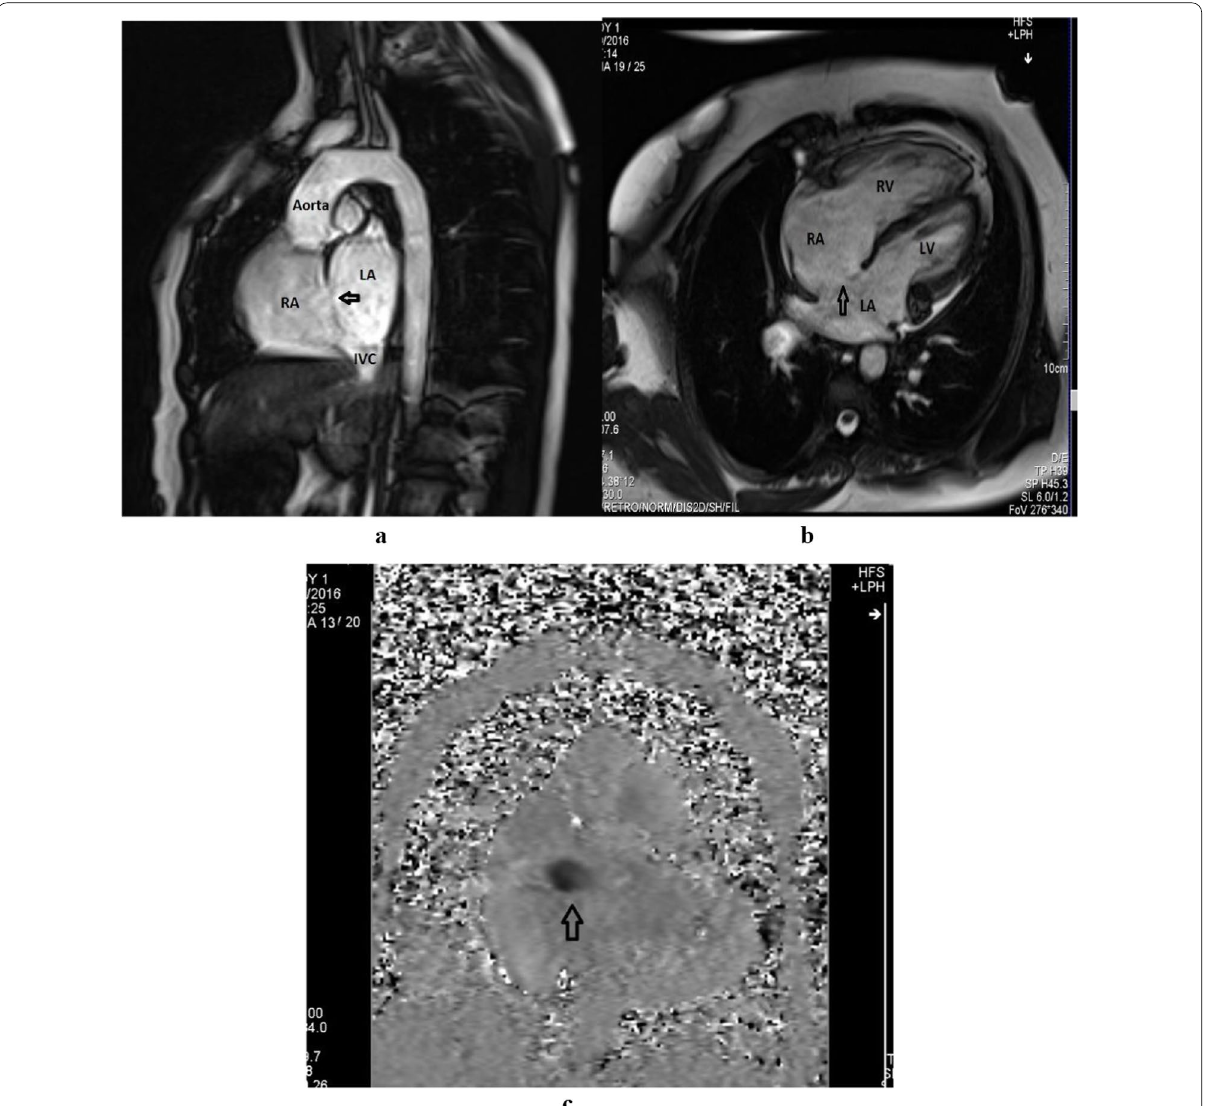
Fig. 2 Phase contrast CMR images depicting ASD (arrow heads) in Oblique Sagittal view ( a ), Axial/Four chamber view ( b ), and enface view ( c ). Note: ASD, Atrial Septal Defect; CMR, Cardiac Magnetic Resonance